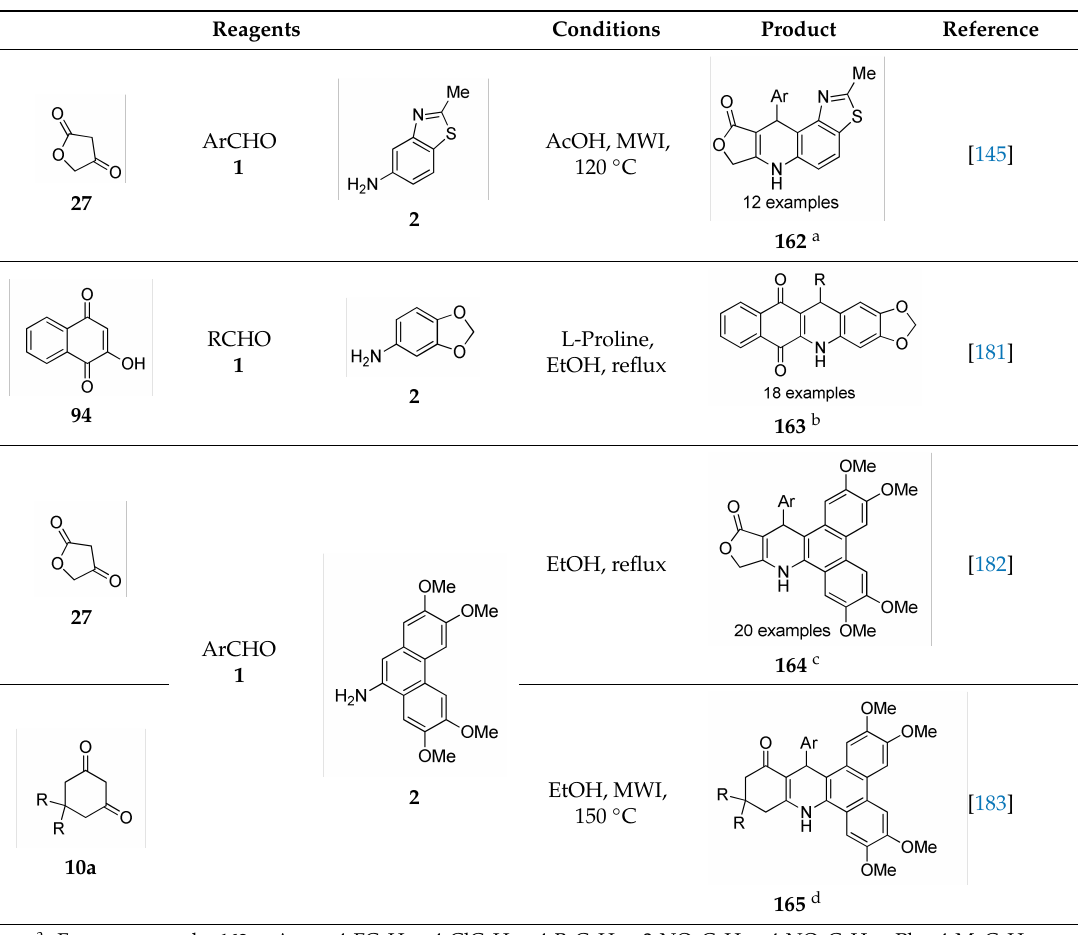
Table 3. Multicomponent synthesis of fused dihydroquinolines 162 – 165 for evaluation of their potential anticancer